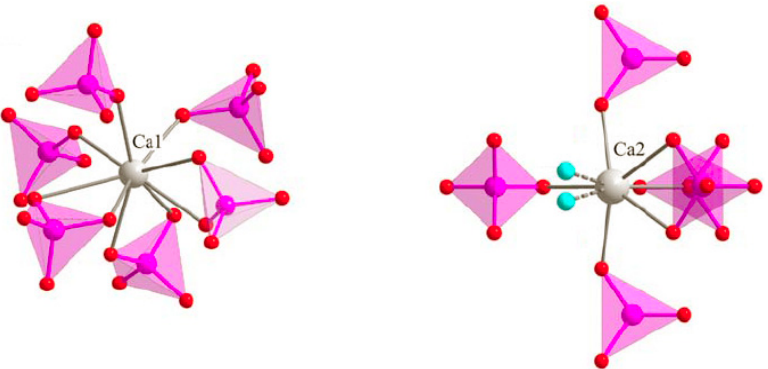
Figure 7. Local environment of the two calcium crystallographic sites in the HAp structure ( gray spheres represent the calcium atoms, pink tetrahedra represent the phosphate groups, and light blue spheres represent the half-occupied hydroxyl position).